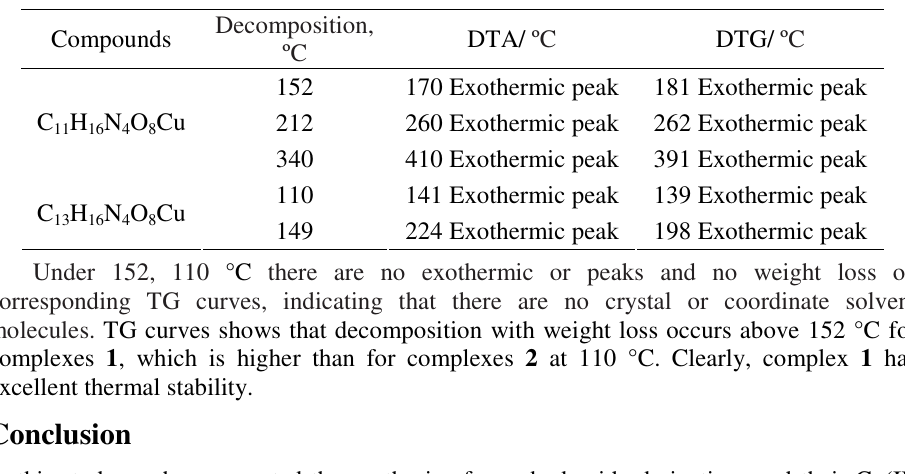
Table 3. Thermal analyses of the